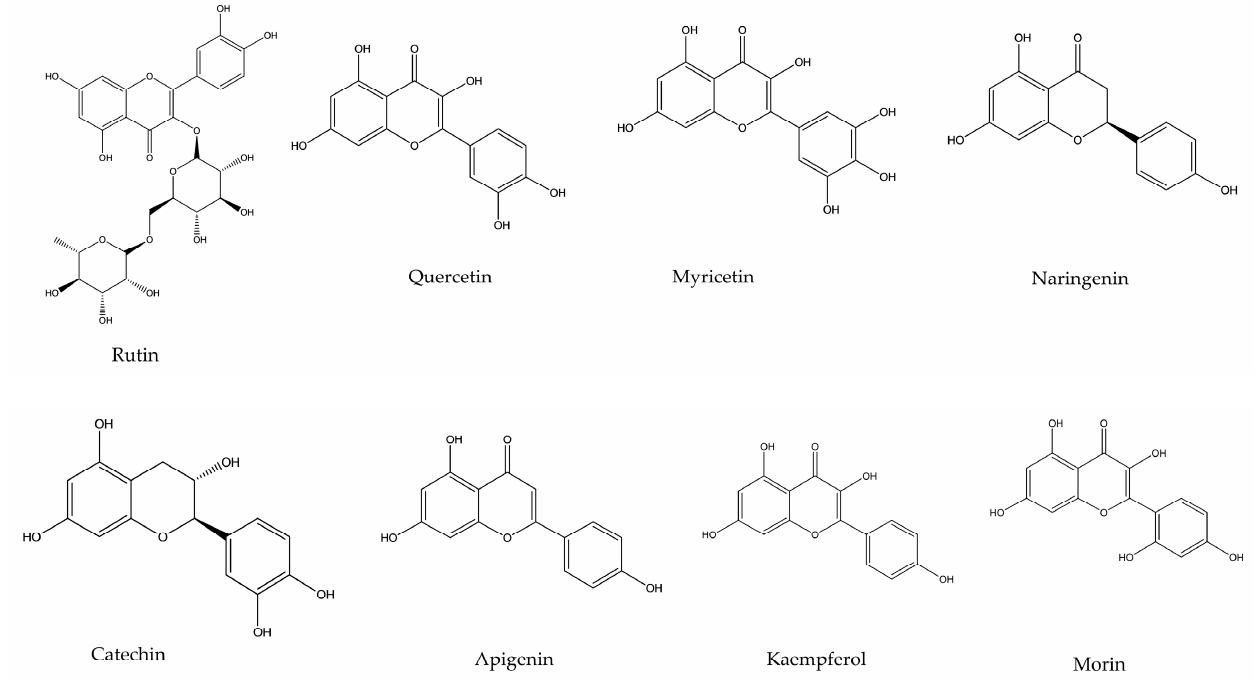
Figure 2. Chemical structure of commonly found